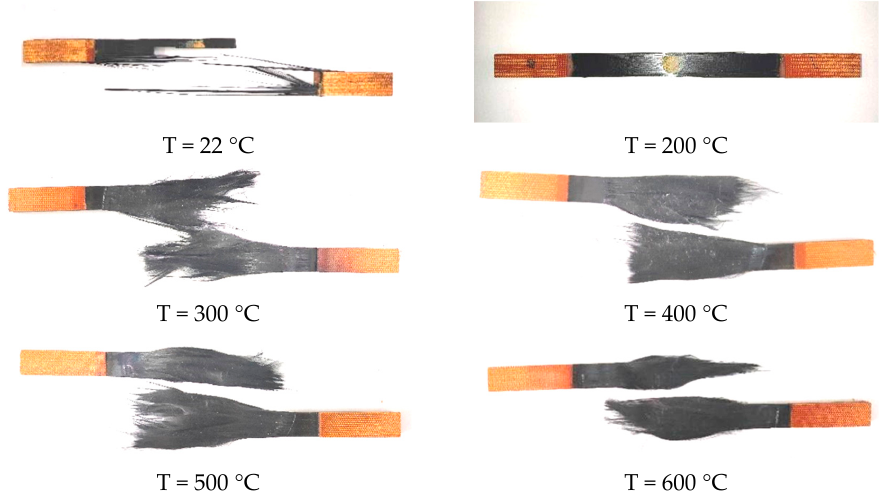
Figure 8. Failure modes of CFRP plate specimens at different temperatures.